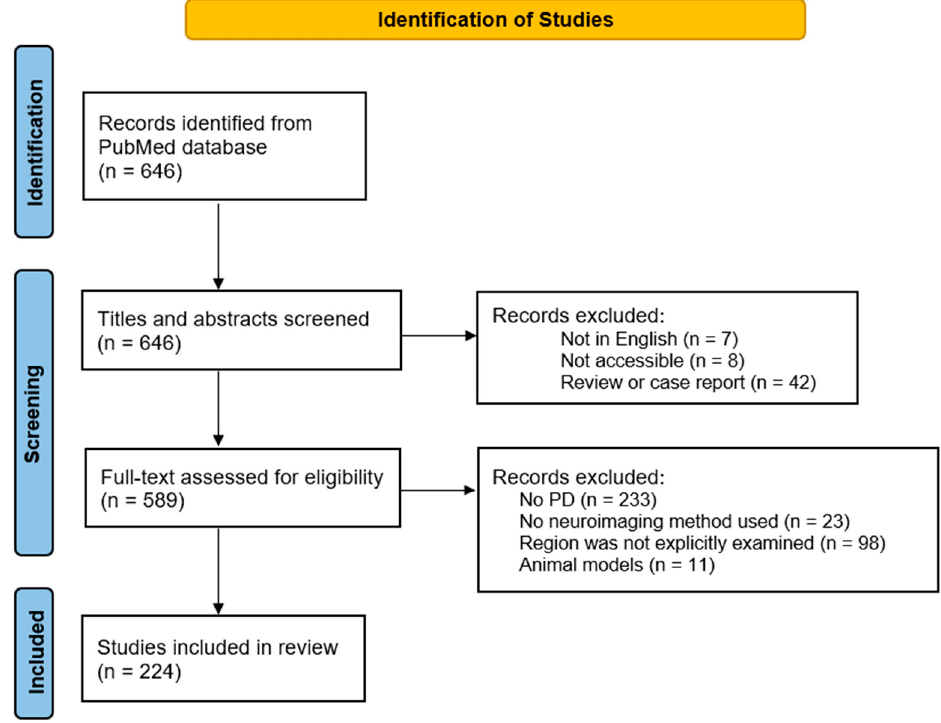
Figure 1. Preferred reporting items for systematic reviews and meta-analyses (PRISMA) flow dia- gram.